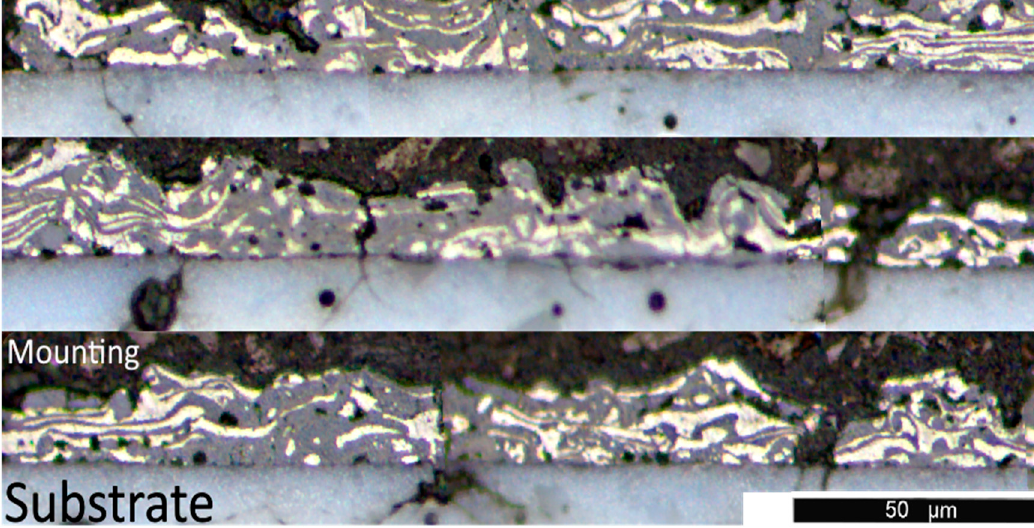
Figure 5. A composite optical image of the cross-section of the unablated film in three locations.